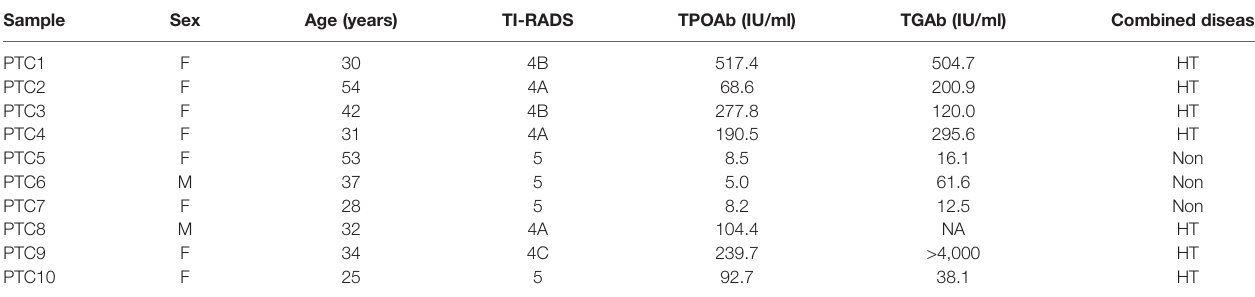
TABLE 2 | Clinical characteristics of thyroid tumor samples. Sample